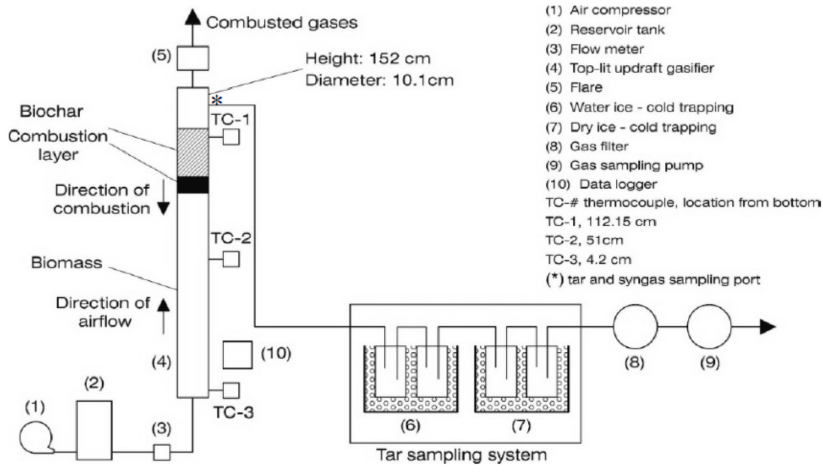
Figure 1. The top ‐ lit updraft biomass gasification system setup. Figure 1. The top-lit updraft biomass gasification system